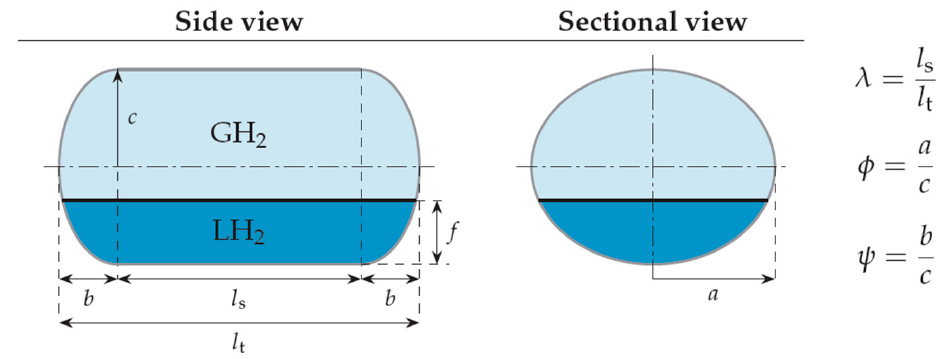
Figure 1. Production of geometric shapes of tanks through three geometric ratios of their main characteristic dimensions [5].